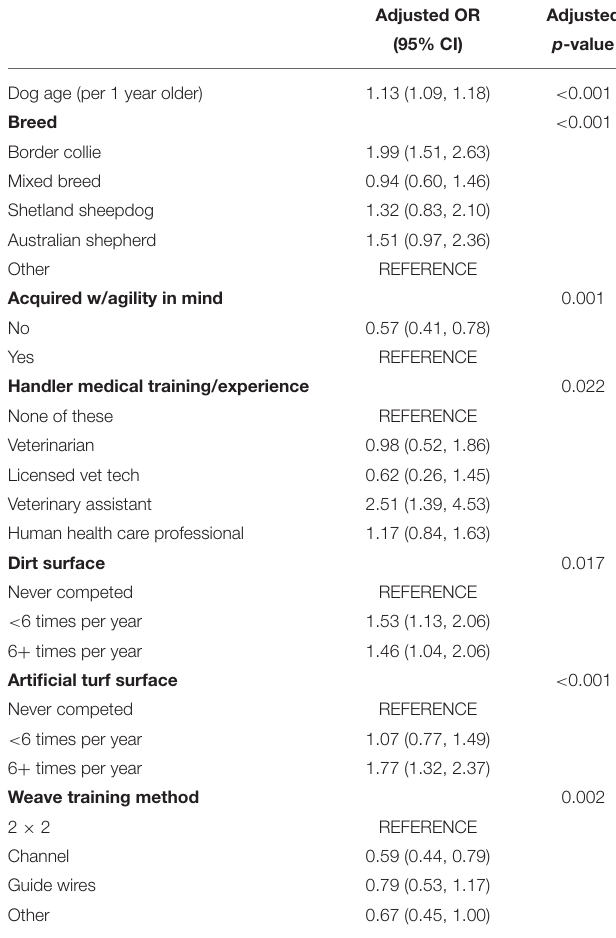
TABLE 2 | Coefficients from final adjusted model of risk factors of iliopsoas injury.